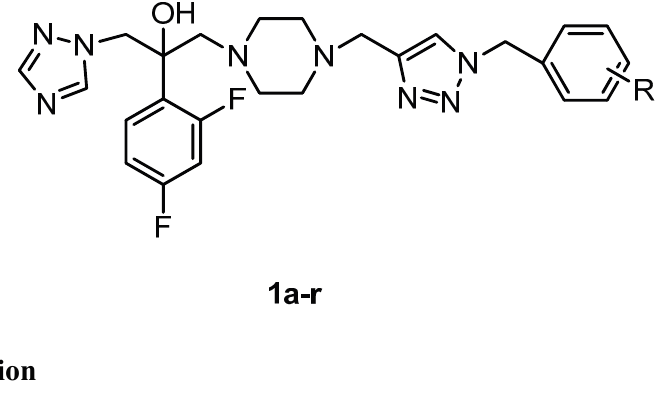
Figure 2. Generic structure of the designed fluconazole